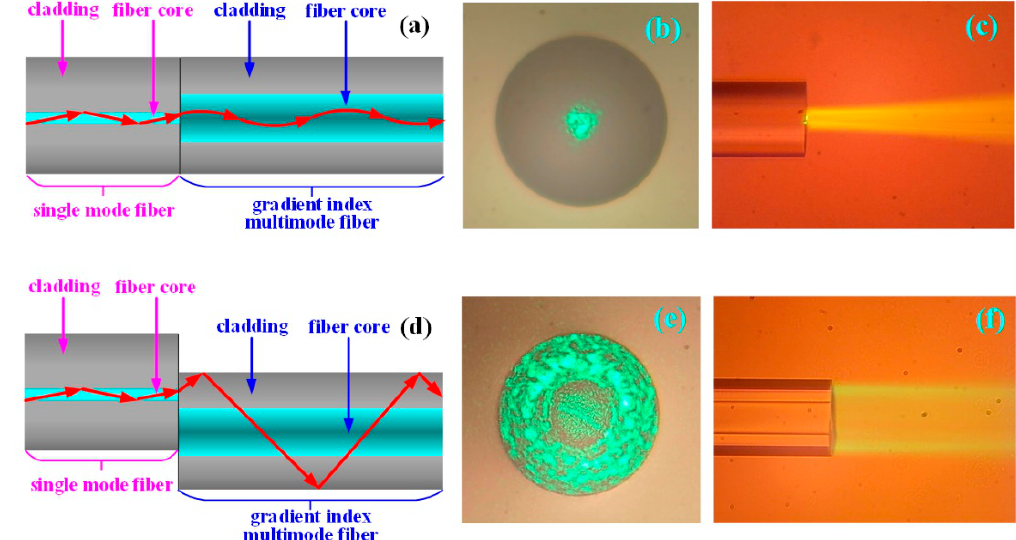
Figure 2. The investigation of the transmission of the light filed of the gradient refractive index multimode fiber when normalized core welding and core-shift welding are used. ( a ) The schematic diagram of the structure and the light transmission of the gradient refractive index multimode fiber when normalized welding is used. ( b ) Microphotograph of the light field from the end face of the gradient refractive index multimode fiber when normalized core welding is used. ( c ) Microphotograph of the light field from the side face of the gradient refractive index multimode fiber when normalized core welding is used. ( d ) The schematic diagram of the gradient refractive index multimode fiber structure and light transmission when core-shift welding is used. ( e ) Microphotograph of the light field from the end face of the gradient refractive index multimode fiber when core-shift welding is used. ( f ) Microphotograph of the light field from the side face of the gradient refractive index multimode fiber when core-shift welding is used.